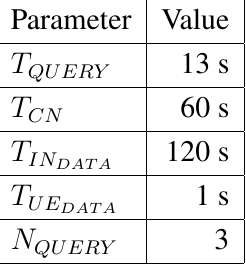
Table 1. Protocol parameter